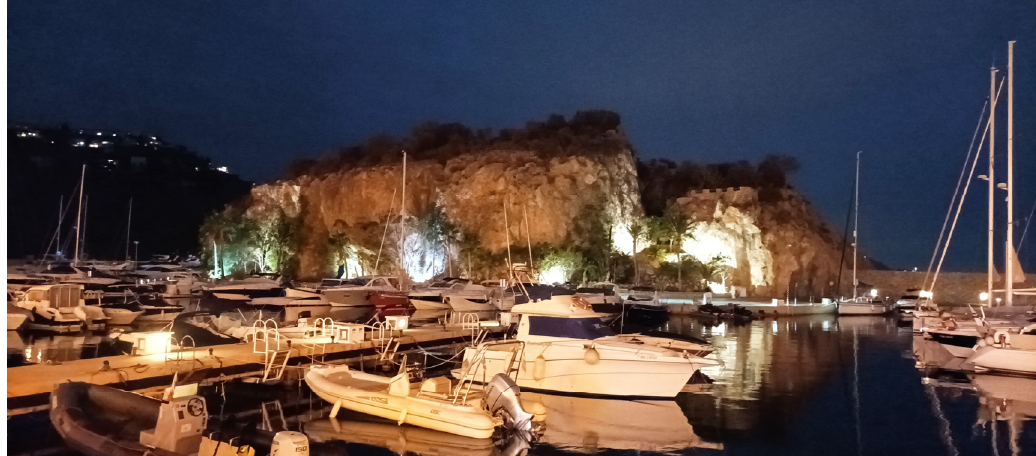
Figure 4. View of the Peñón de las Caballas (photograph by authors, October 2022).